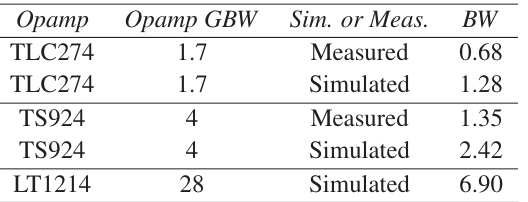
Fig. 3: Output impedance ( Ω ) versus frequency ( Hz ). Simulations of the circuit with different opamps gave results shown in table 1. Tab. 1: Measured and simulated bandwidths, unit for all parameters is MHz